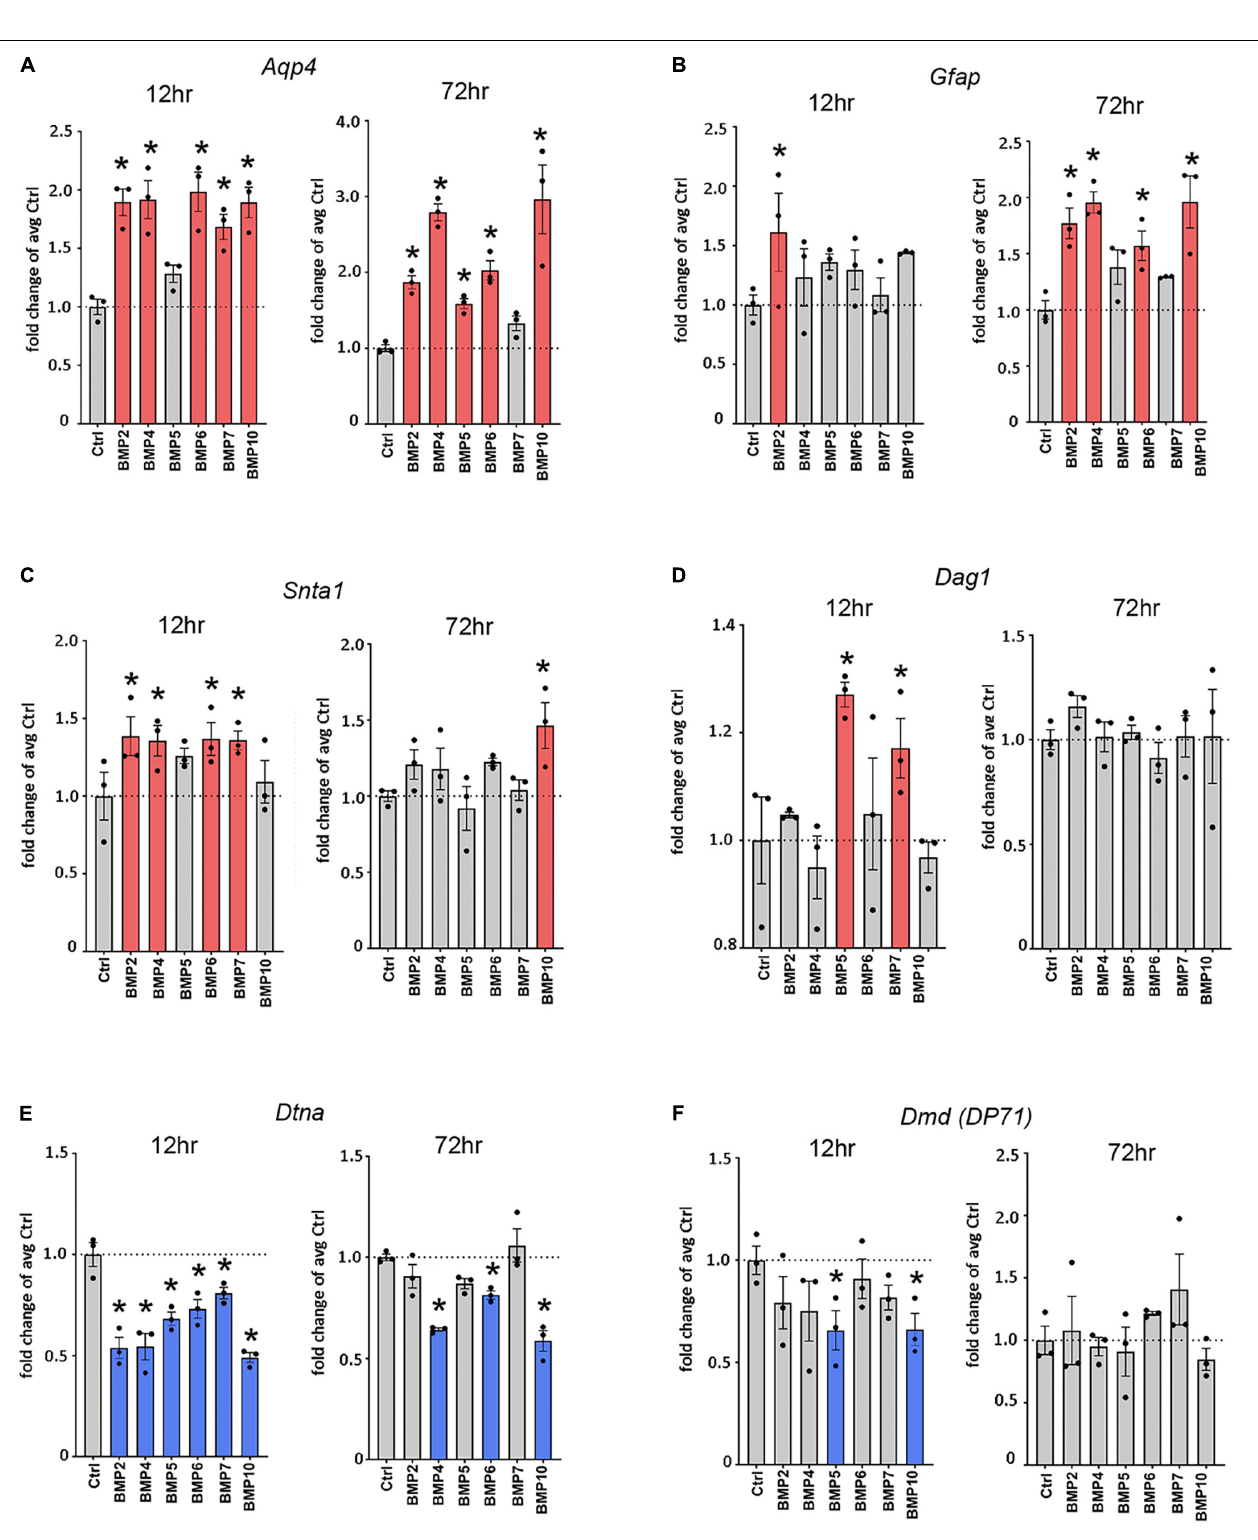
FIGURE 2 | Canonical BMPs transcriptionally regulate Aqp4 , Gfap, and DAP complex genes. RT-qPCR of Aqp4 (A) , Gfap (B) , DAP complex genes Snta1 (C) , Dag1 (D) , Dtna (E) , and Dmd (F) ; (DP71 transcript variant) on cDNA from BMP treated primary mature astrocytes confirms transcriptional regulation by canonical BMPs. Transcripts differentially regulated by BMPs at 12 and 72 h. Expression is shown as fold changes compared to untreated cells (Ctrl). Red coloring indicates significant upregulation; Blue coloring indicates significant downregulation. *Sig ANOVA LSD post-hoc test; error bars: SEM; dots: individual sample values; P < 0.05; n = 3.